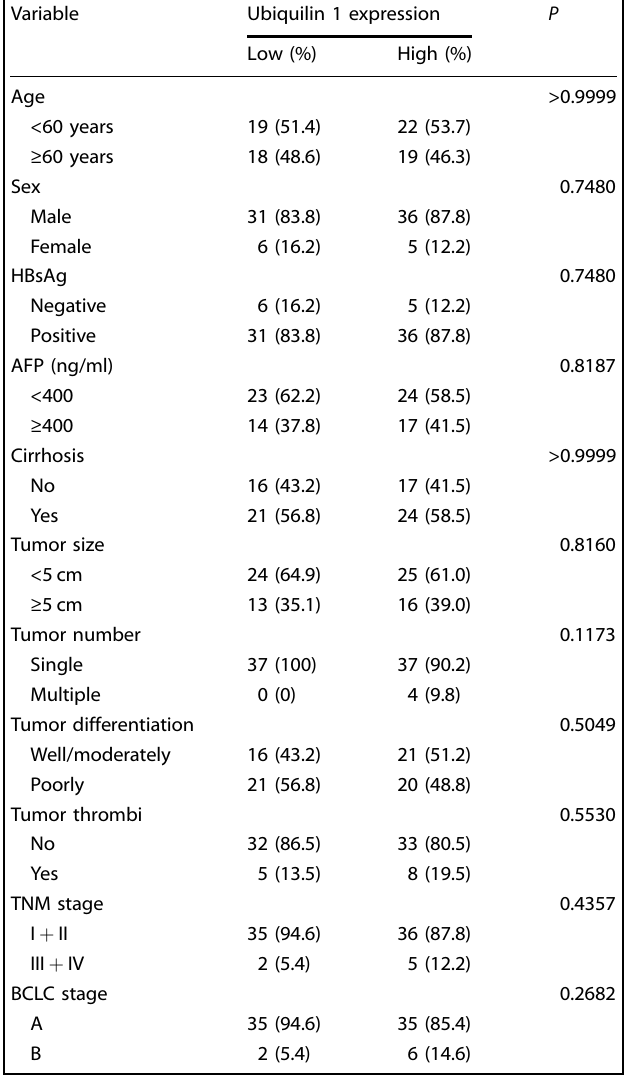
Table 1. Association between ubiquilin 1 expression